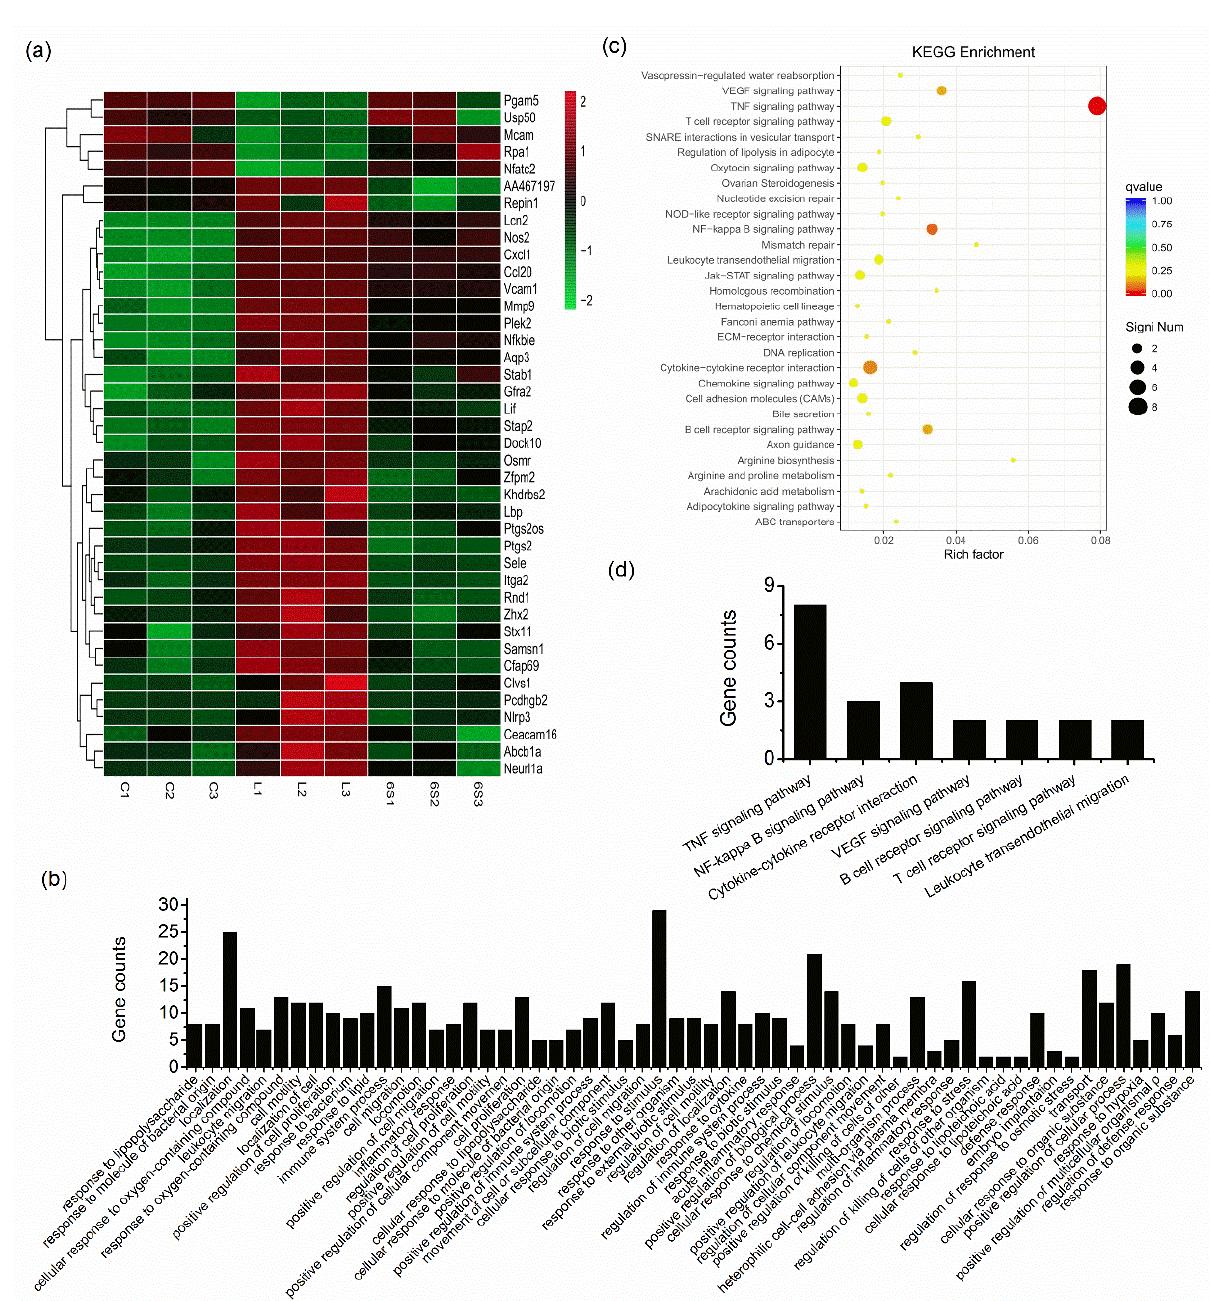
Figure 3. Transcriptomic analysis for mice liver tissues. ICR mice received daily oral administrations of 6-shogaol (20 mg/kg) for 7 consecutive days. The control and LPS groups were administered with the vehicle. On day 8, mice in LPS and 6-shogaol groups received an i.p. injection of LPS (10 mg/kg). After 24 h, the mice were sacrificed: ( a ) hierarchical cluster heatmap for the overlap differentially expressed genes based on expression values (log 2 (TPM + 1)). Samples are displayed in columns and genes in rows. The color represents gene expression level, i.e., brighter red indicates higher expression values and brighter green indicates lower expression values; ( b ) GO (biological process) terms enriched for overlapped differentially expressed genes; ( c ) KEGG pathway enrichment for overlapped differentially expressed genes. The top 30 pathways are presented. The Y-axis and X-axis indicate functional pathways and the enrich factor for the differentially expressed genes, respectively; ( d ) gene counts in each enriched pathway (presenting pathways with gene counts > 2).